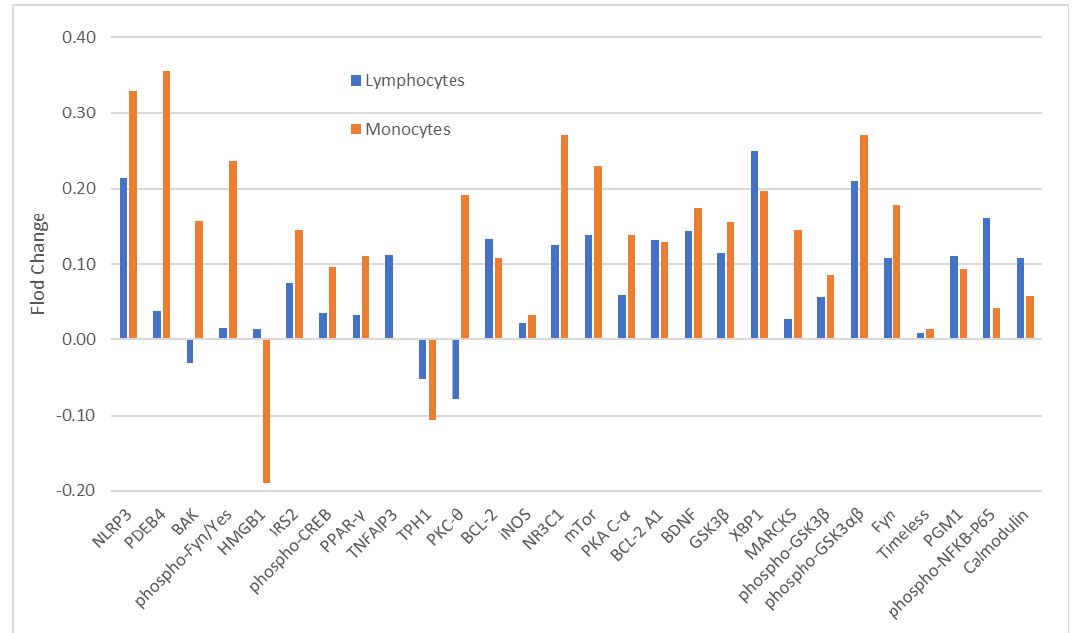
Figure 1. Fold change (FC) of 28 analytes in monocytes and CD4 + lymphocytes at baseline between lithium responders and non ─ responders. Note: FC = log2 (median fluorescent ratio of non ─ responders/median fluorescent ratio of responders). Positive value is indicative of a higher level of protein expression in lithium non ─ responders than in lithium responders. Negative value is indicative of a lower level of protein expression in lithium non-responders than in lithium responders. Abbreviations: BAK: BAX, BCL2 ─ Associated X Protein; BCL ─ 2: B-cell lymphoma 2; BCL ─ 2 A1: Bcl ─ 2-related protein A1; BDNF: brain ─ derived neurotrophic factor; Calmodulin: calciummodulated protein; Fyn: a tyrosine kinase belongs to the Src family of tyrosine kinases including src, fyn,